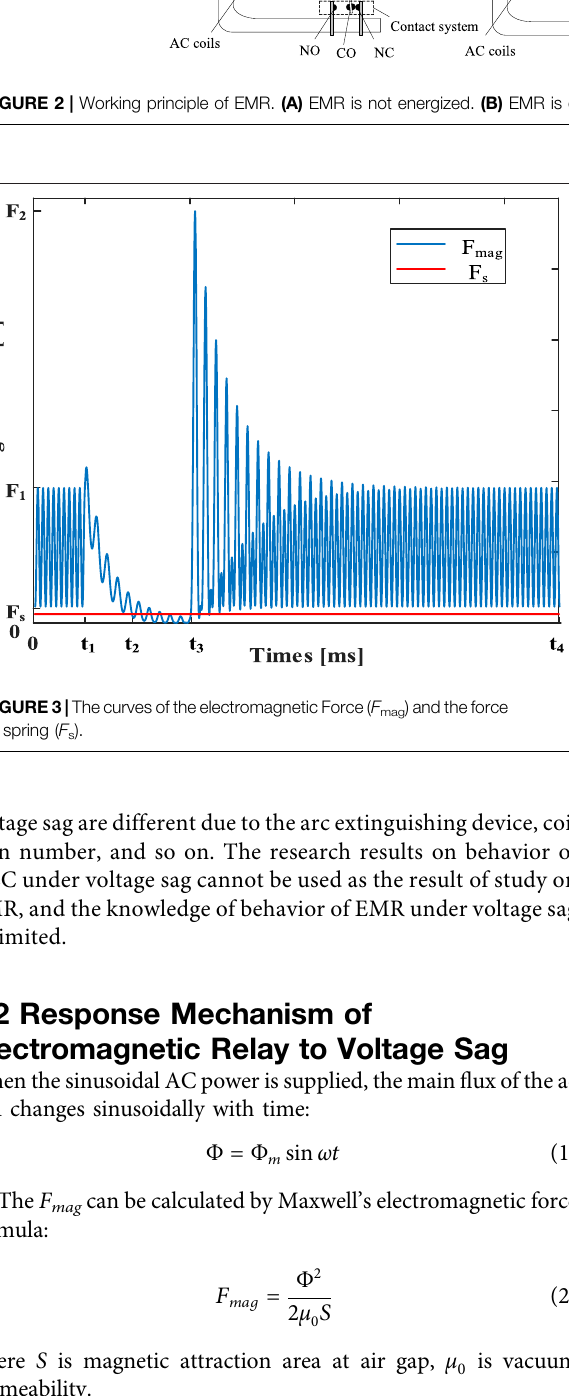
Frontiers in Energy Research |